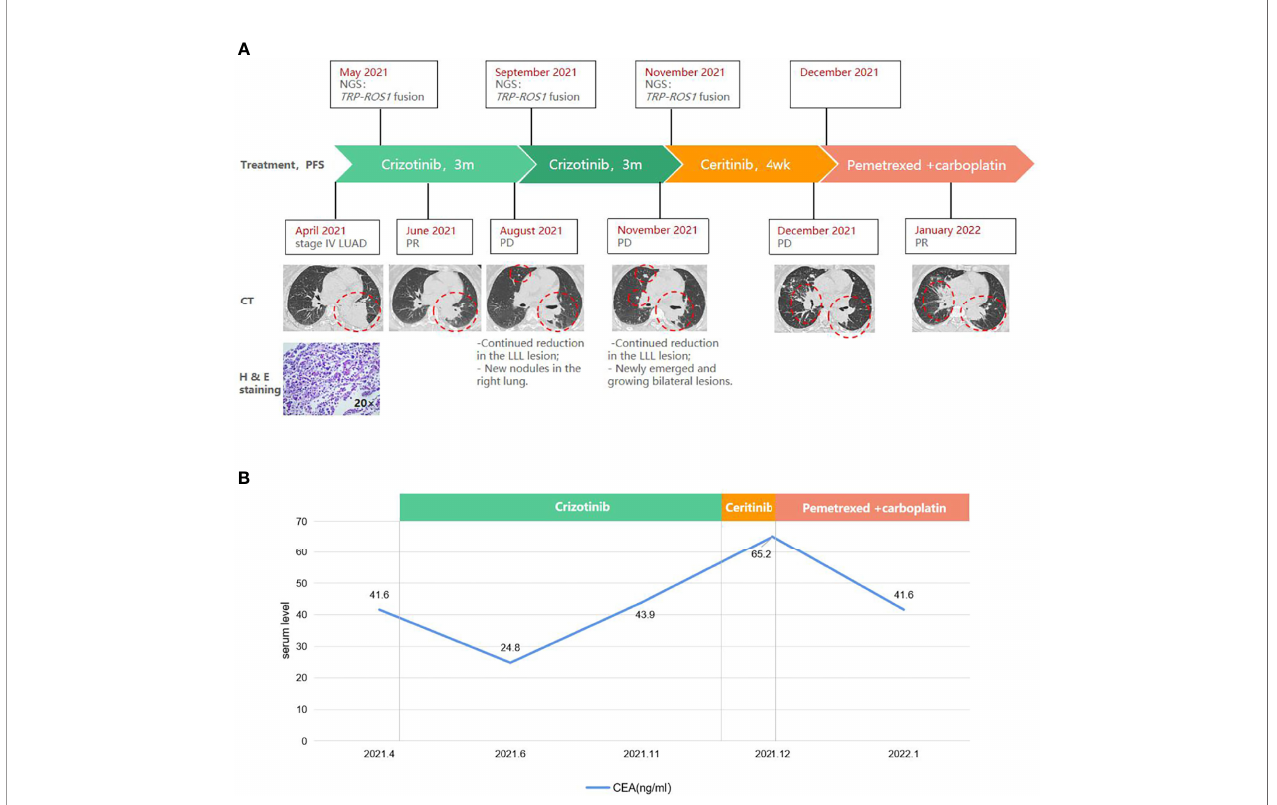
FIGURE 1 | A schematic diagram of the course of management highlighting (A) radiographic, histopathologic, and molecular fi ndings, and (B) carcinoembryonic antigen (CEA) levels at key time points. Red circles indicate the target lesion. CT, computed tomography. H & E, hematoxylin and eosin. LLL, left upper lobe. LN, lymph node. LUAD, lung adenocarcinoma. Met, metastasis. PD, progressive disease. PR, partial response. TPR , translocated promoter